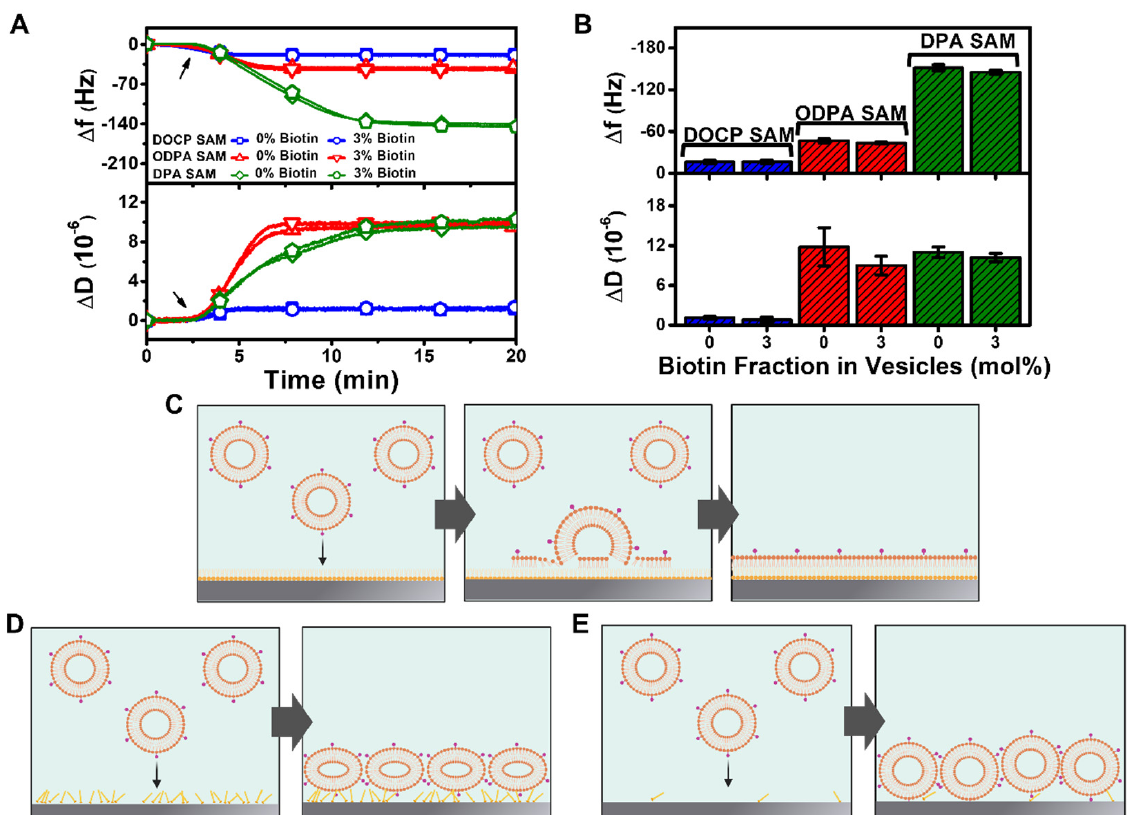
Figure 4. QCM-D tracking of vesicle adsorption and HLB formation on functionalized TiO 2 surfaces. ( A ) Time-resolved ∆ f and ∆ D signals are reported for adsorption of vesicles containing 0 or 3 mol% biotinylated lipid onto TiO 2 surfaces functionalized with DOCP, ODPA, or DPA molecules. The arrow indicates the start of vesicle addition. ( B ) Summary of final ∆ f and ∆ D shifts for vesicle adsorption corresponding to data in panel ( A ). The data are presented as the mean ± standard deviation from n = 3 runs. Schematic illustration of vesicle adsorption outcomes on TiO 2 surfaces functionalized with ( C ) DOCP yielding HLB formation, ( D ) ODPA yielding intact vesicle adlayer formation (more deformed), and ( E ) DPA yielding intact vesicle adlayer formation (less deformed). On the DOCP-functionalized surface, vesicles adsorbed monotonically, resulting in upper monolayer formation, and the one-step formation kinetics in this case are consistent with vesicle fusion driven by hydrophobic forces [6]. The interaction process resulted in HLB formation, and the corresponding ∆ f and ∆ D shifts for the vesicle addition were around − 16.3 ± 2.3 Hz and 1.1 ± 0.2 × 10 − 6 , respectively, for vesicles containing 0 mol% biotinylated lipids, which were within typical range for monolayer formation. Similar ∆ f and ∆ D shift values of around − 16.4 ± 2.3 Hz and 0.8 ± 0.4 × 10 − 6 , respectively,